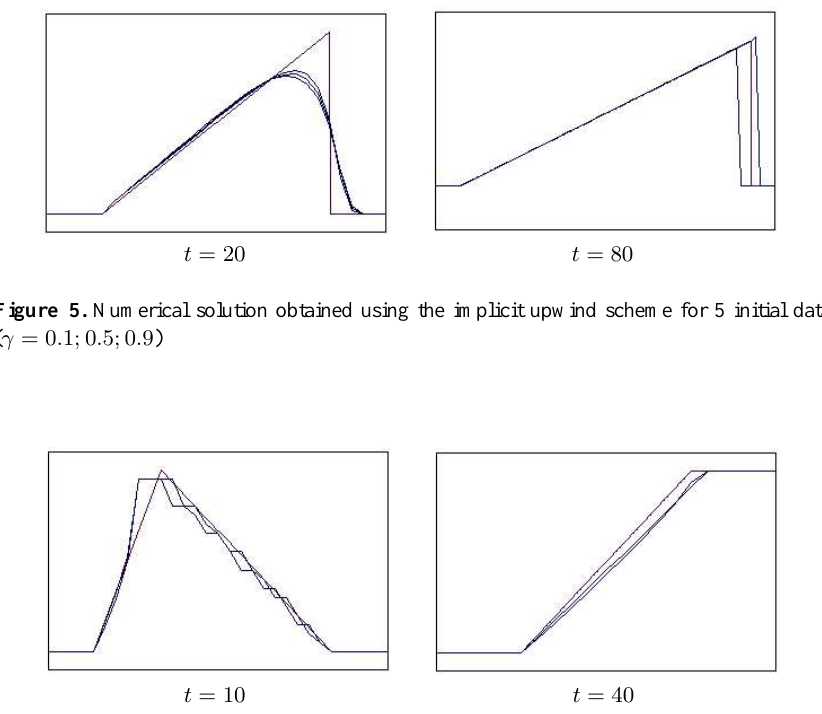
Figure 6. Numerical solution obtained using the implicit upwind scheme for 6 initial data ( (cid:13) = 0 : 1; 0 : 5; 0 : 9